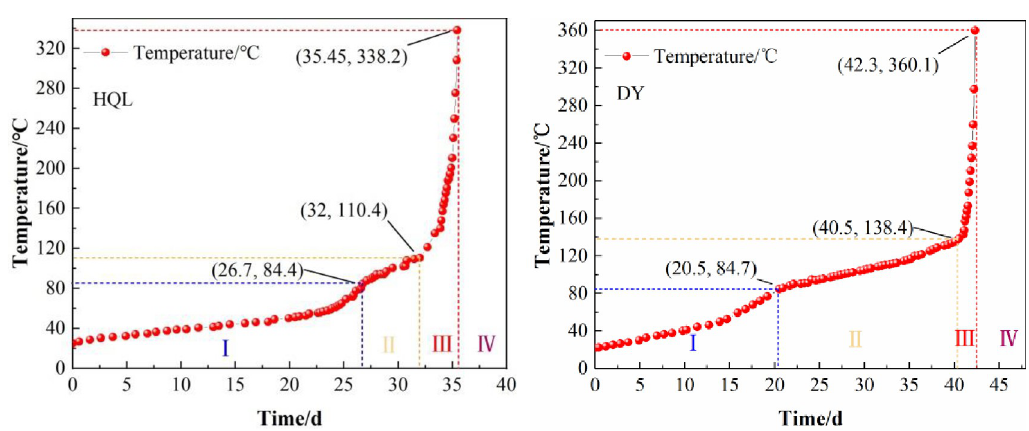
Fig 5. Upward trend of coal spontaneous combustion.